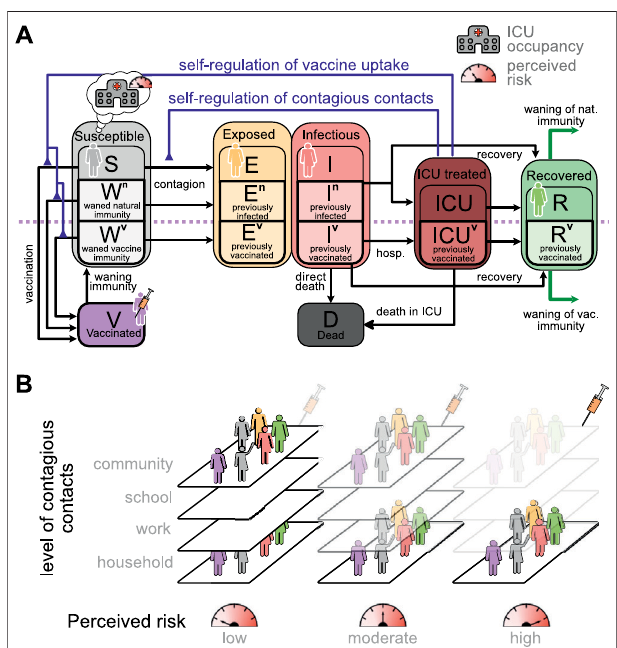
FIGURE 1 | Interplay between risk perception and voluntary health- protectivebehavior. (A) :Sketchoftheproposedage-strati fi edcompartmental model of disease spread, which incorporates different stages for disease progression and immunologicalconditions of the susceptible population with their respective chances of being infected and developing a severe course ( Supplementary Figure S1 , Supplementary Information, for full model). The behavioral feedback (blue lines) changes individuals ’ contagious contact behavior, as well as their willingness to get vaccinated, and hence the effective spreading rate. (B) : We use the contact matrix of [12], which yields the contact rates at home, school, work and in the community for each age- group. For the subsequent scenarios, we adapt these contexts of contacts separately. Some of the contacts are by de fi nition hard to reduce voluntarily (e.g., household contacts), while others (at school and work) strongly depend on current mandatory non-pharmaceutical interventions ( Supplementary Figure S3 for